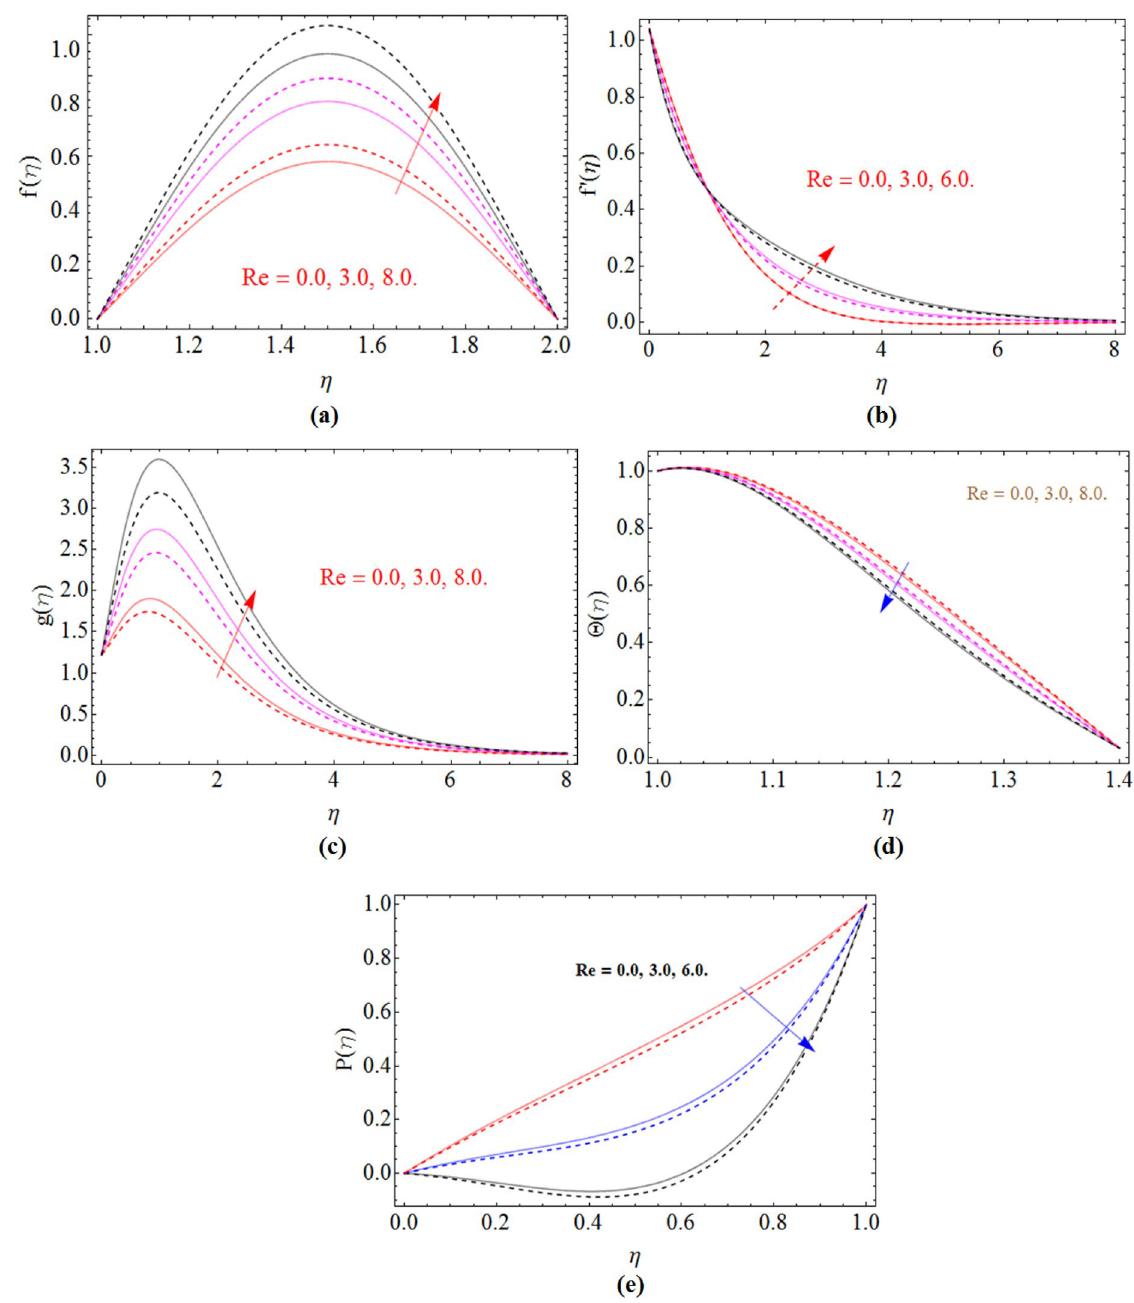
pressure profile P (η) , for S 2 , when S 1 = 0.0. dashed lines for (cid:31) = 0.5 and lines for (cid:31) = −